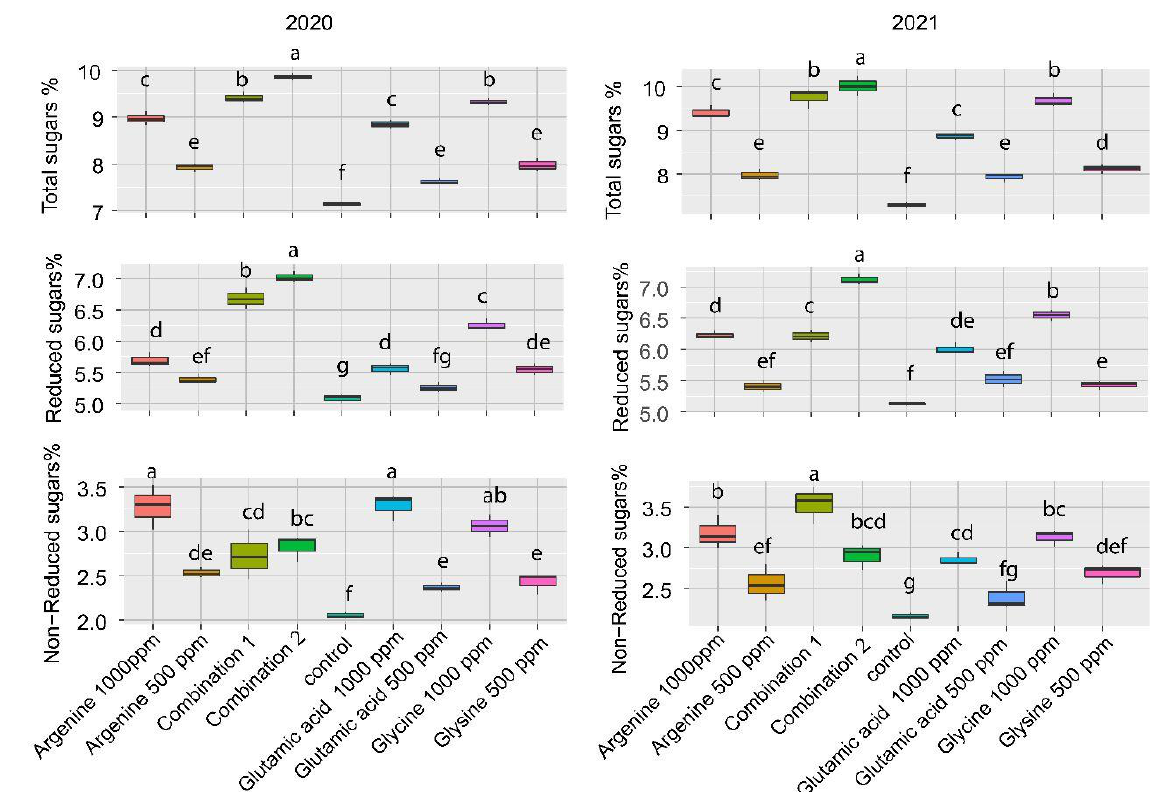
Figure 2. The influence of glutamic acid, arginine, and glycine amino acids on the fruit content from total, reduced and non-reduced sugars percentages of guava during the 2020 and 2021 seasons. Treatments with the same letter have no significant differences between them.